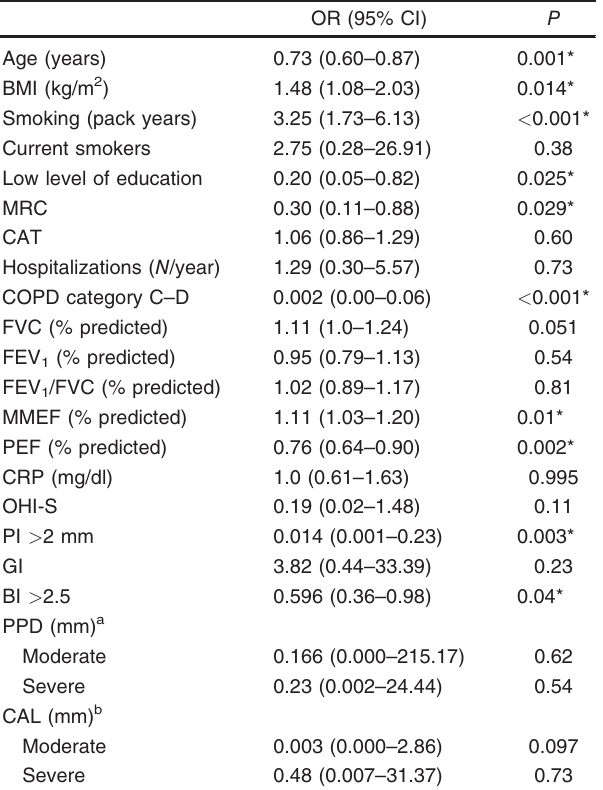
Table 5 Logistic regression for frequency of exacerbations concerning patients ’ periodontal health variables, after adding demographic, clinical, and spirometry